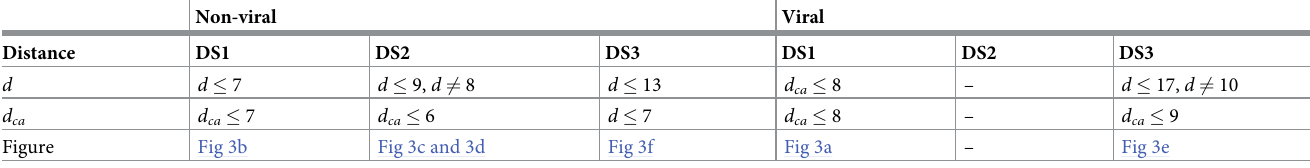
d and d ca —are defined in Table